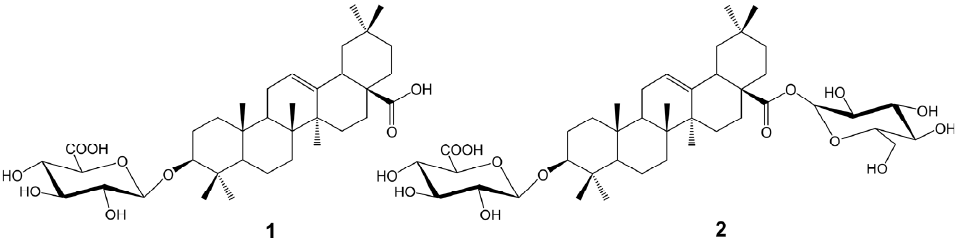
Figure 1. The structures of compound 1 and 2 .